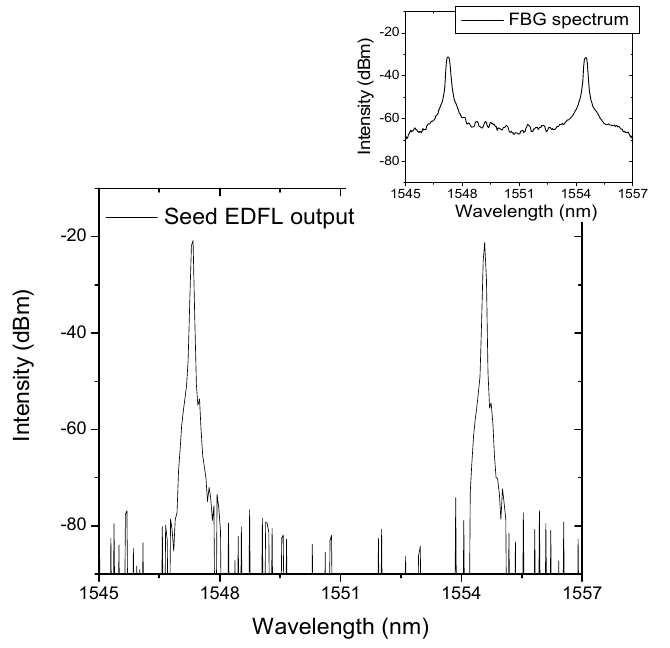
Figure 2. Spectrum of Seed EDFL output. Inset shows the spectrum of two tunable fiber Bragg